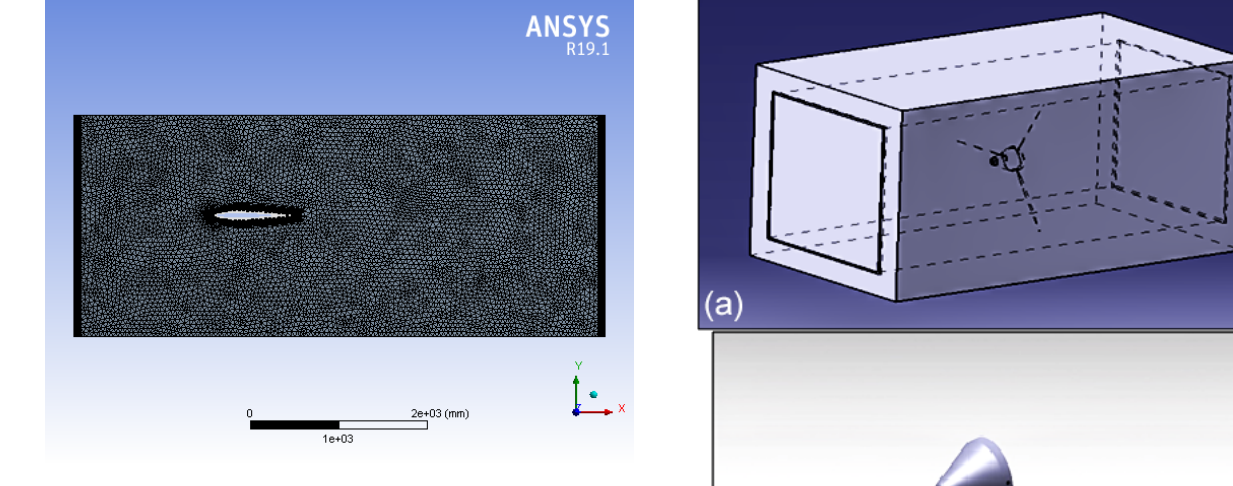
Figure 3. 2D meshed airfoil for Fluent analysis for NACA 0012 at a 0 ◦ blade twist angle.